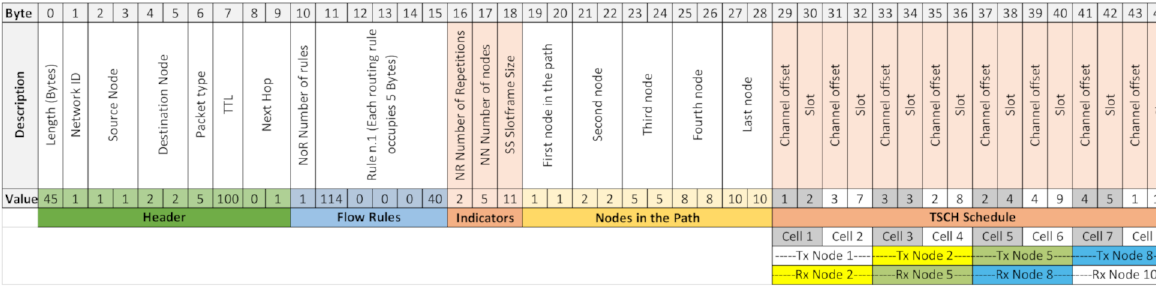
Figure 7. OpenPathTSCH packet structure for a 5-node